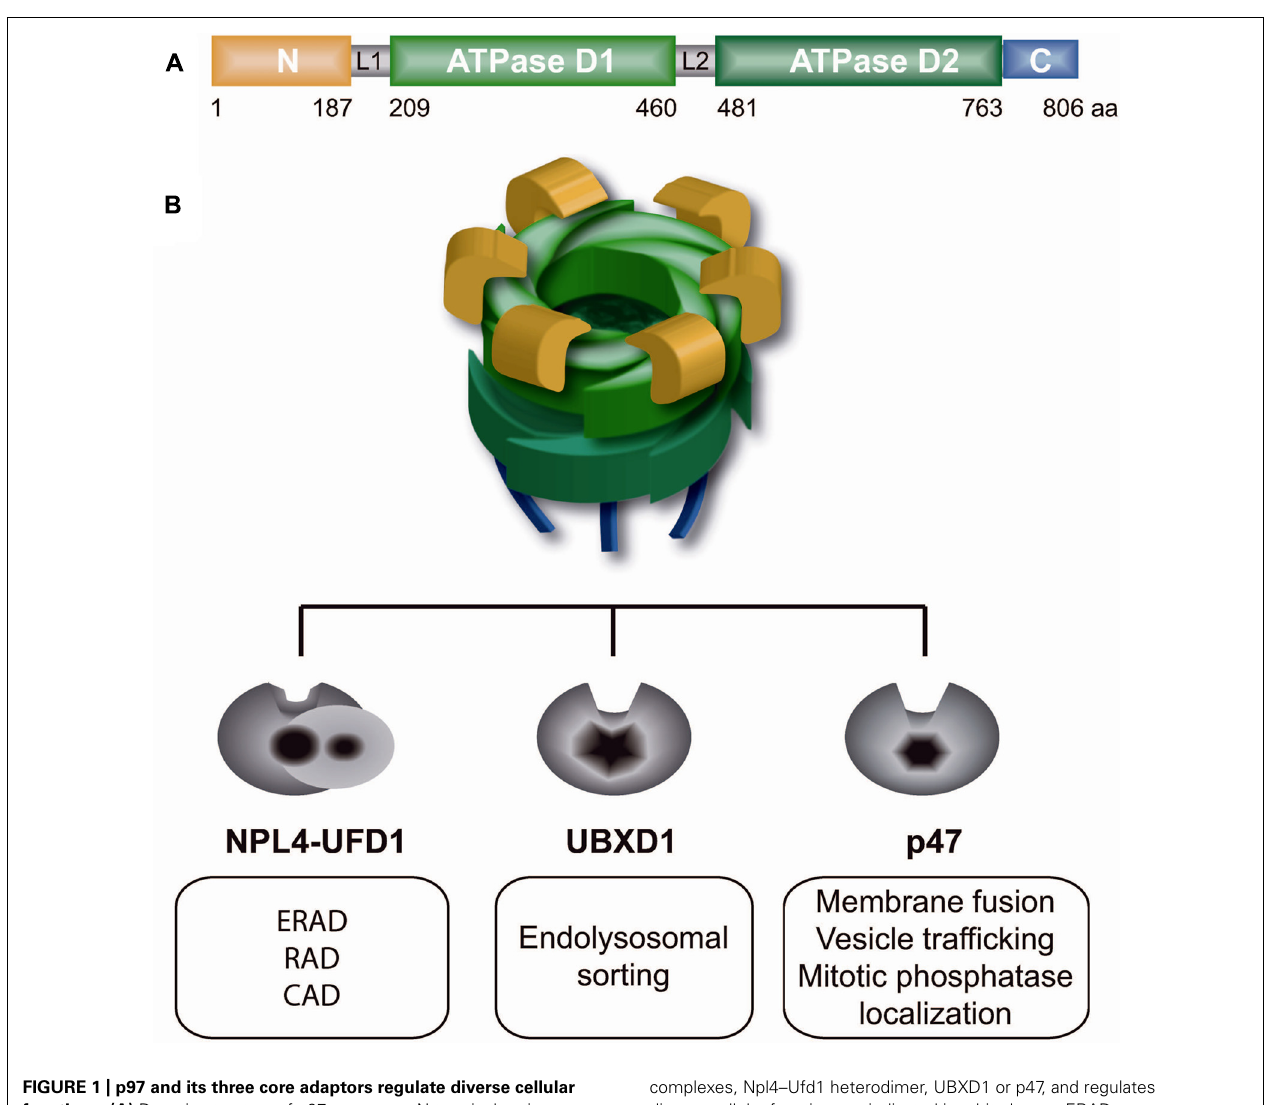
FIGURE 1 | p97 and its three core adaptors regulate diverse cellular functions. (A) Domain structure of p97 monomer: N-terminal region (yellow), L1 and L2 linker regions (gray), two ATPase cassettes D1 and D2 (green), and the C-terminal tail (blue). (B) p97 homohexamer forms a barrel-like structure that mutually binds one of three core adaptor